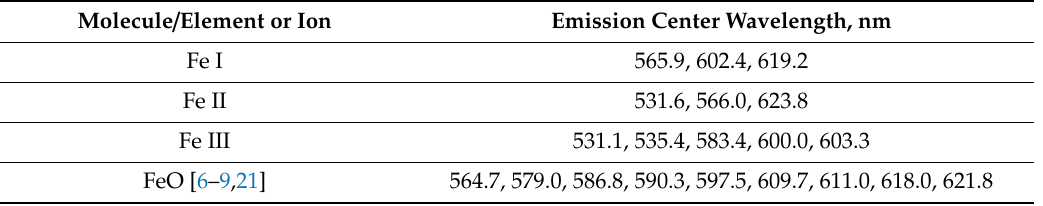
Table 2. Spectral emission lines and bands emission identification